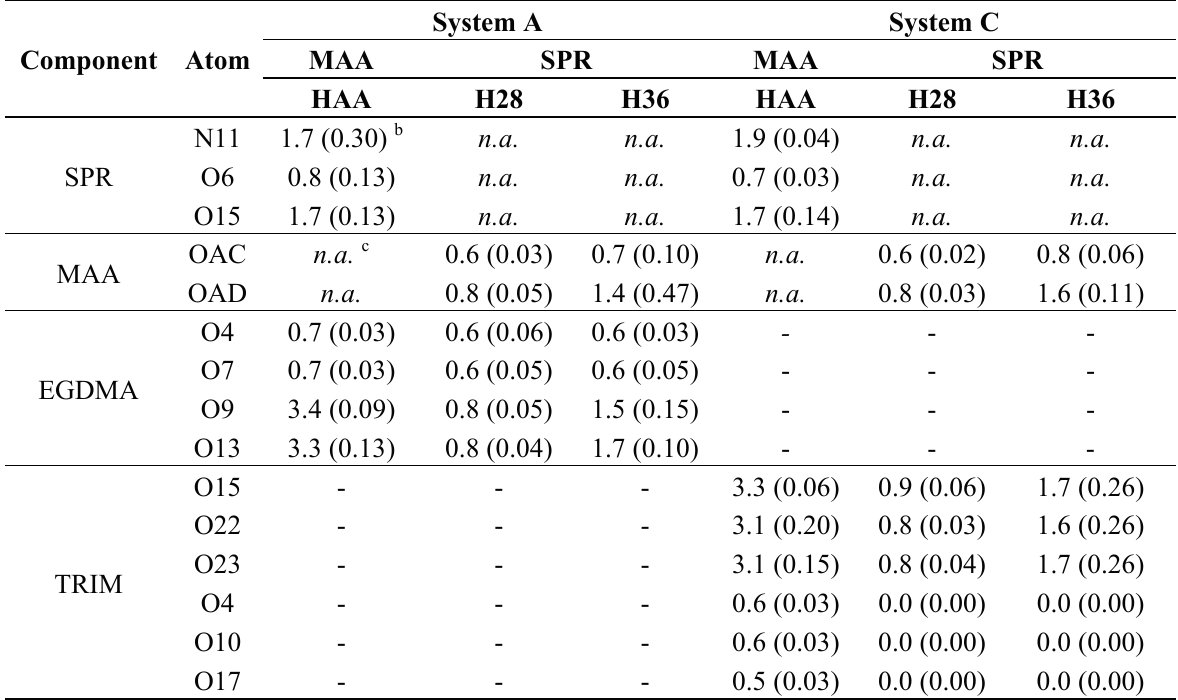
Table 4. Observed average hydrogen bond lifetimes a